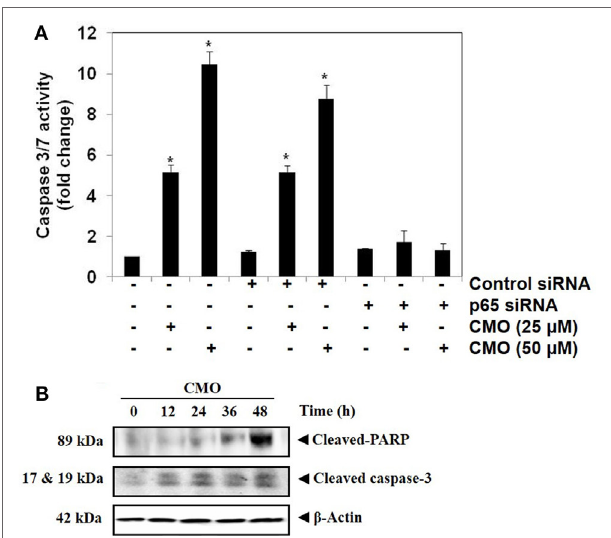
FigUre 5 | (a) Knockdown of p65 by small interfering RNA (siRNA) reduces the apoptotic effect of CMO. HepG2 cells were transfected with either control or p65 specific siRNA (50 nM). After 48 h, the cells were treated with CMO (25 or 50 µM) for 24 h, and the enzymatic activity of caspase-3/7 was determined by Caspase-Glo ® 3/7 assay kit. (B) CMO increases the cleavage of PARP and Caspase 3 in HCCLM3 cells. HCCLM3 cells were treated with 50 µM CMO for 12, 24, 36, and 48 h, after which, the whole-cell extracts were prepared, and 30 µg of protein was resolved on 12% SDS-PAGE gel, electrotransferred onto nitrocellulose membranes, and probed for cleaved PARP and cleaved caspase 3 antibodies. The data are expressed as mean ± SD, compared with the untreated control (* p < 0.05).